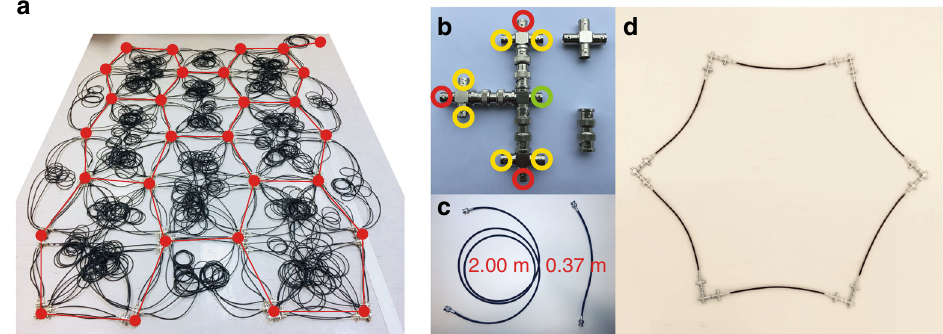
Fig. 4 The transmission line network. a A photo of the experimental sample. The nodes are marked by red dots, which are connected by red lines to illustrate the 2D structure. b A node formed by connectors. The red, yellow and green circles mark the ports for connecting the intralayer, interlayer and measurement cables respectively. c The 2.00 m and 0.37 m long cables. d A hexagon formed by cables and